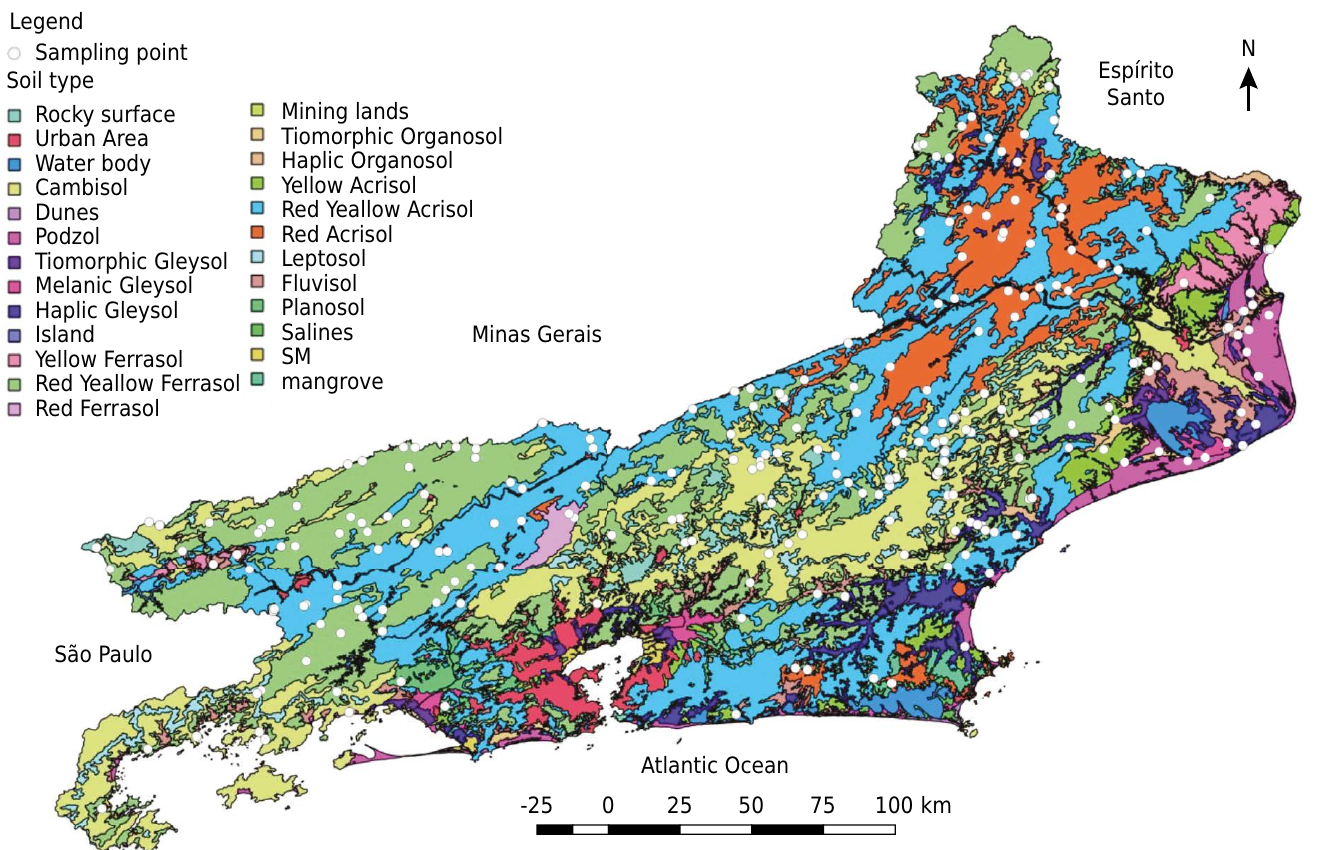
Figure 1. Soil map of the state of Rio de Janeiro (adapted from Carvalho Filho et al., 2003). White points indicate the soil sampling